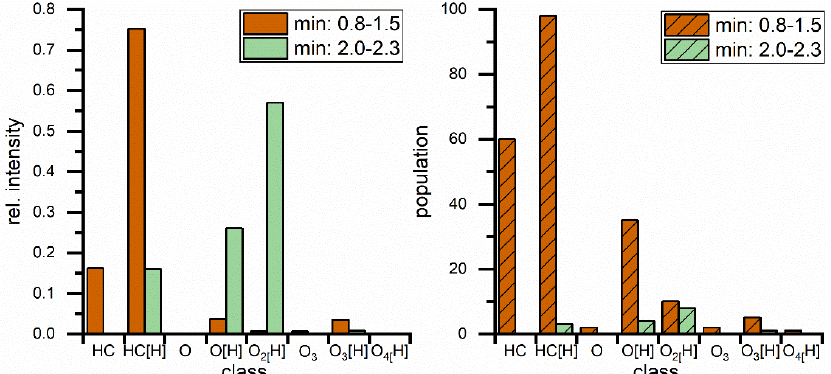
Figure 10. Comparison of major peaks in blend bulk separation regarding class distribution for different hydrocarbon classes with rel. intensities ( left ) and population ( right ) which represents the number of identified compounds. Classes are describing hydrocarbons with different (amounts of) heteroatoms. Square brackets contain the adduct type, no brackets represents radical ions.